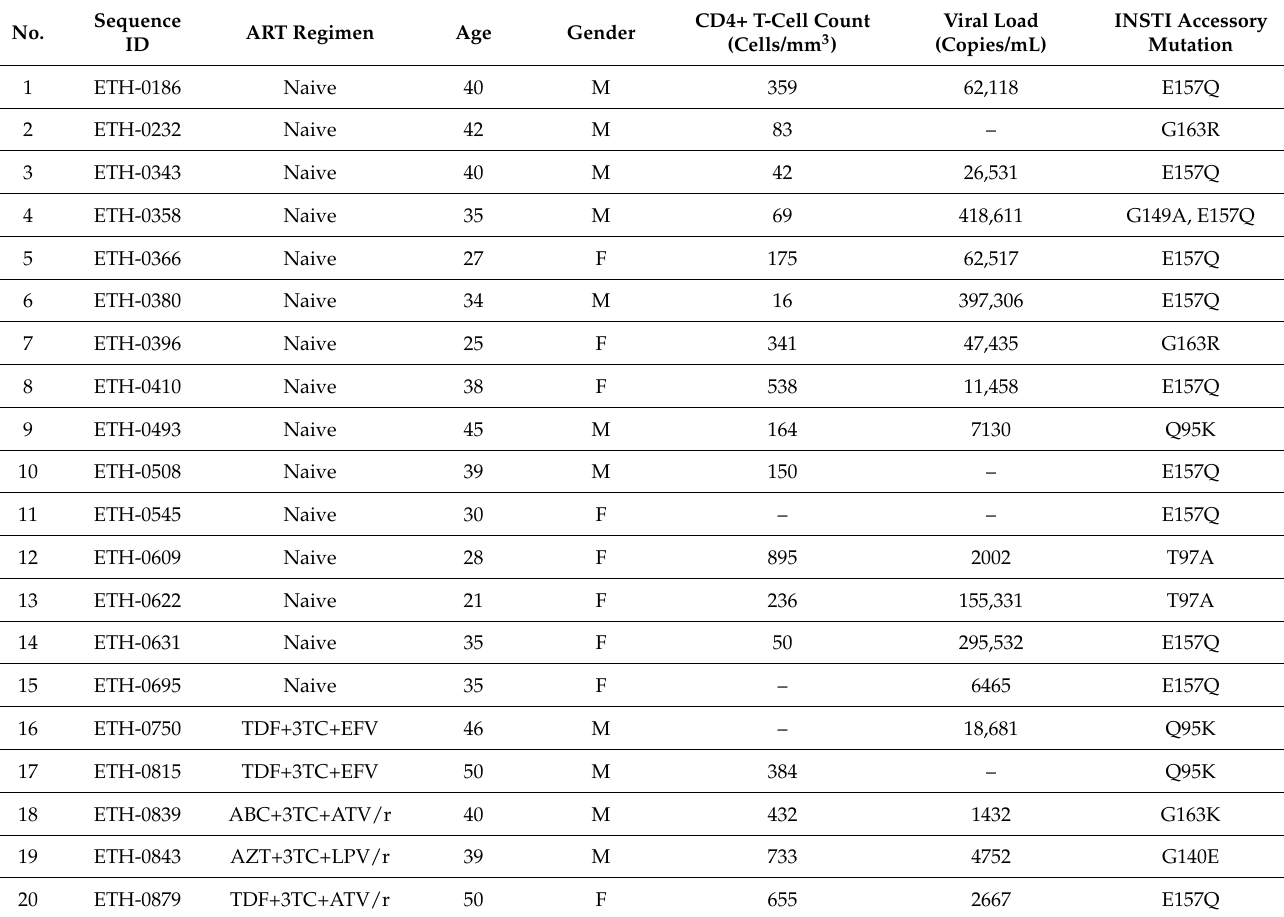
Table 1. Prevalence of integrase accessory mutations detected and their ART